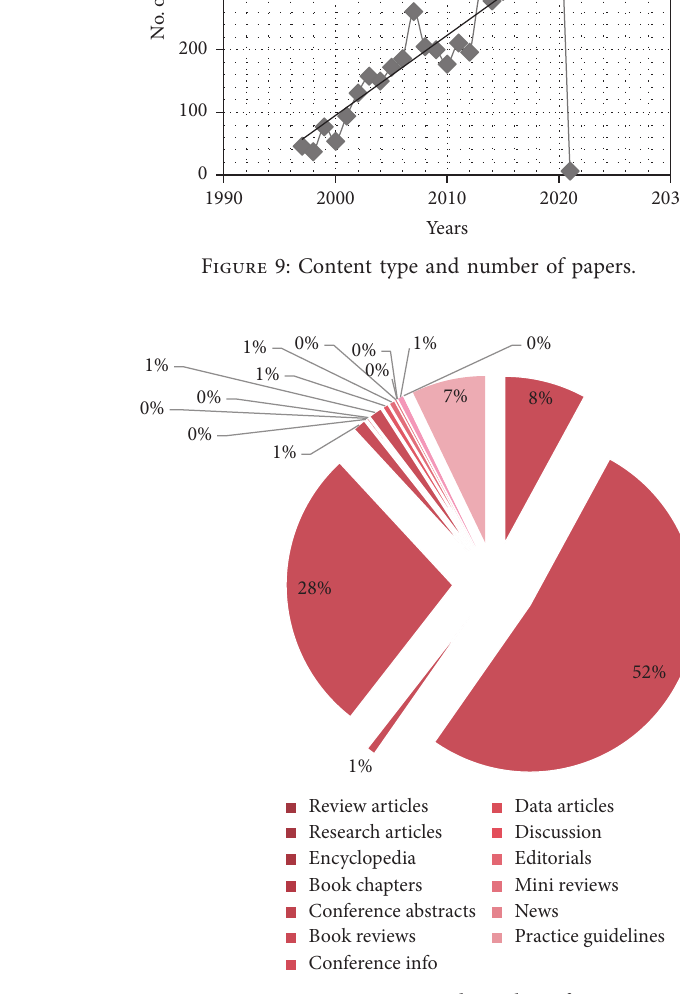
Figure 10: Content type and number of